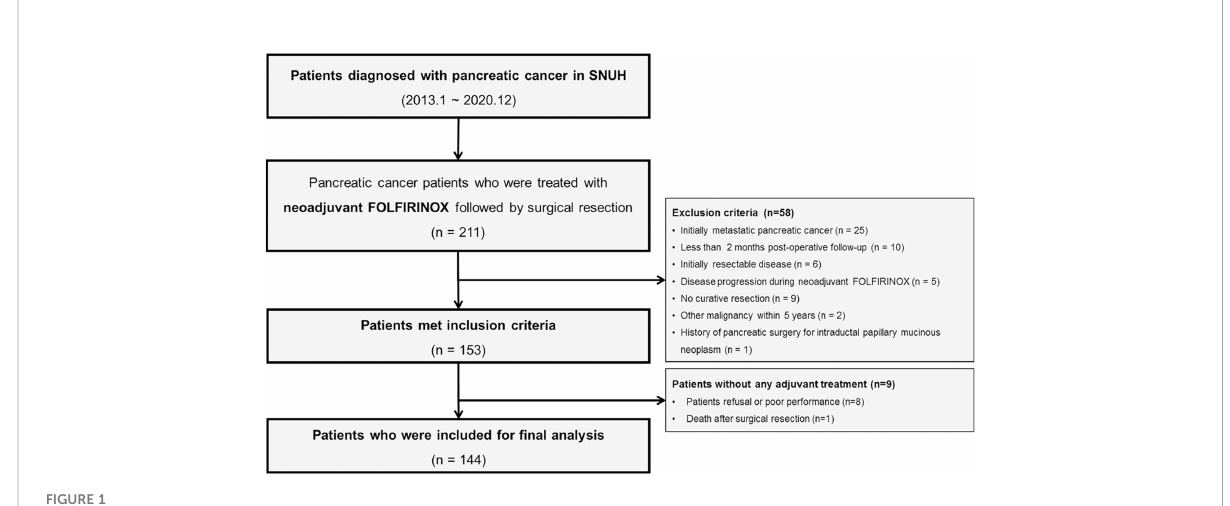
FIGURE 1 Flowchart of this